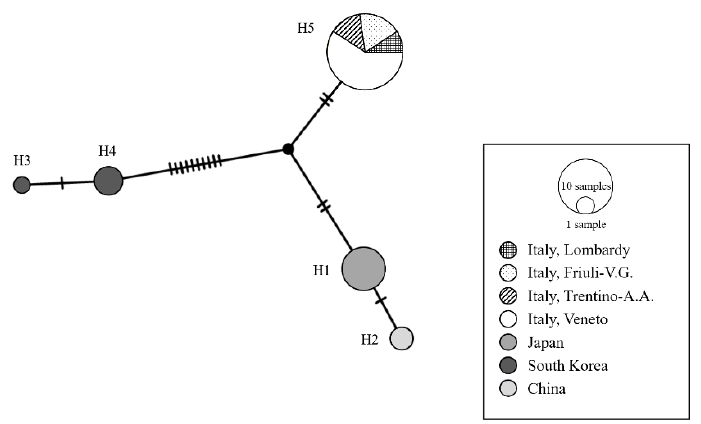
Figure 2. Haplotype network reconstructed with PopART, with the Trissolcus mitsukurii cytochrome c oxidase subunit I (COI) sequences obtained in this study and those present in GenBank. Each haplotype is represented by a circle, with the area of the circle proportional to its frequency. Each line represents a single mutation, while crossing lines symbolize missing intermediate or unsampled haplotypes.